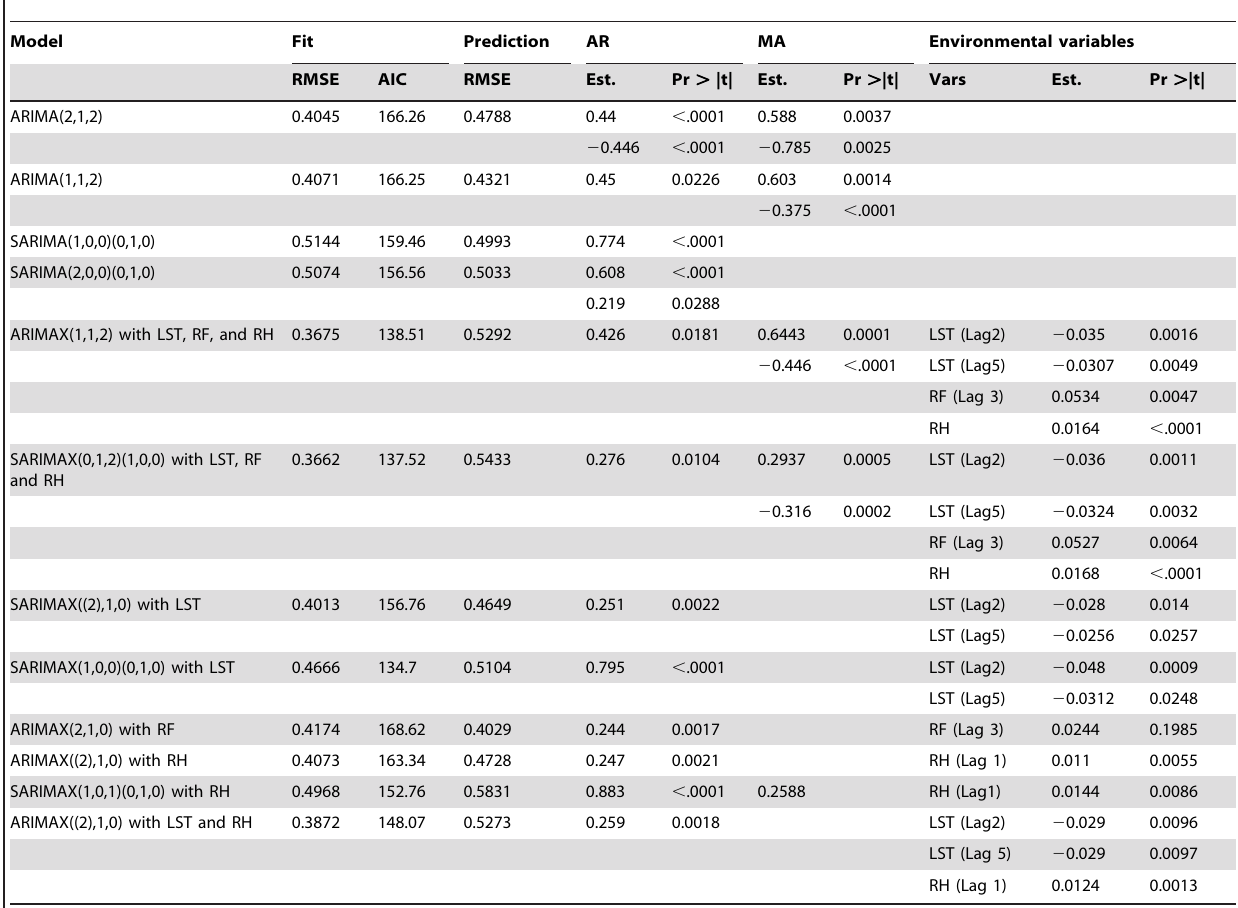
Table 1. Summary of model performance and the estimated coefficients for Hong Kong Influenza.